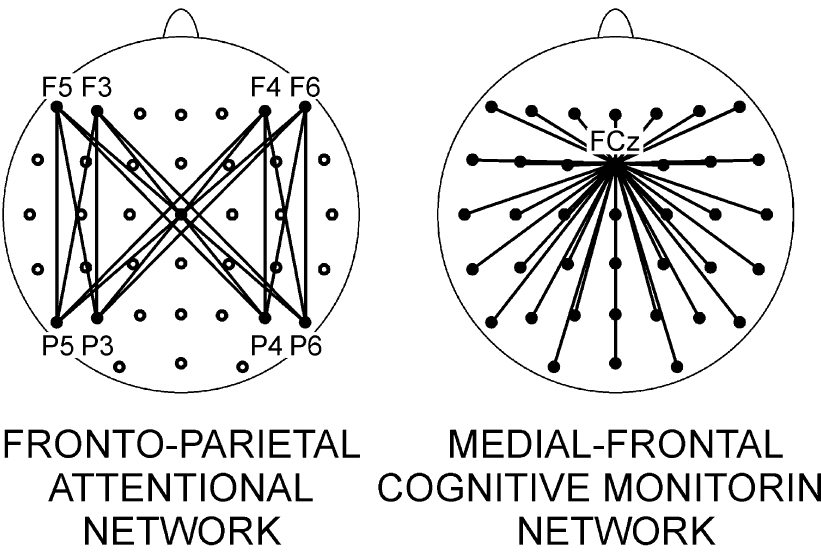
Figure 1. Schematic presentation of attentional and cognitive monitoring networks: fronto-parietal (left) and medial frontal (right). Respective electrodes are labelled according to the International 10–20 system. Electrodes used for analyses are presented in